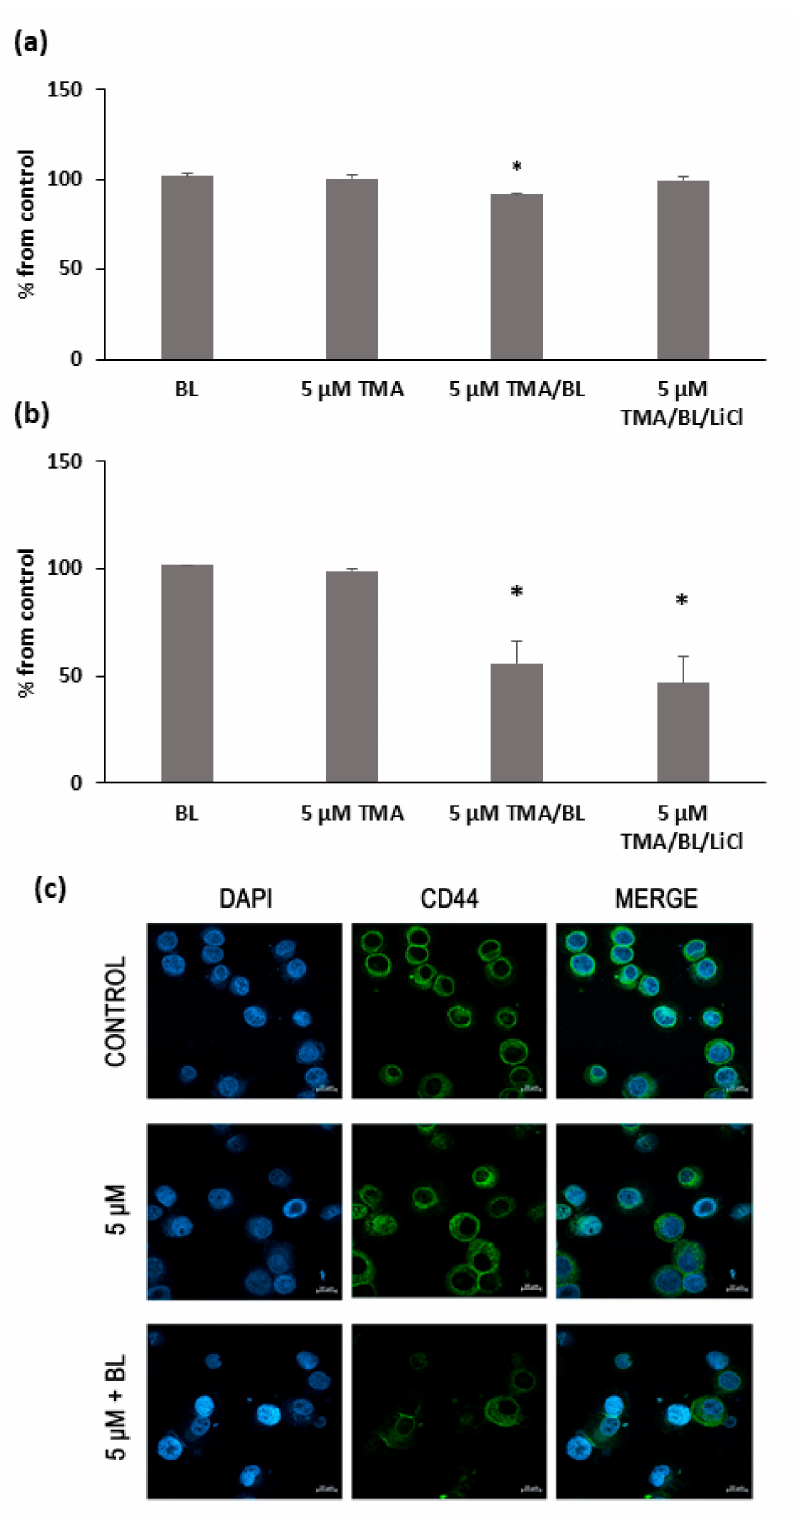
Figure 6. FACS analysis of the CD44 expression at 24 ( a ) and 48 h ( b ) after the treatment with TMA, BL (2 J/cm 2 ), and 1-mM LiCl. Data are reported as % of positive cells compared to the control cultures. The results are expressed as percentages from the control cultures. * = p < 0.05 vs. the control cultures. ( c ) Immunofluorescence with anti-CD44 antibody at 24 h after the treatment with TMA/BL (2 J/cm 2 ). Nuclei and CD44-positive areas are in blue and green fluorescence, respectively (bar: 20 µ